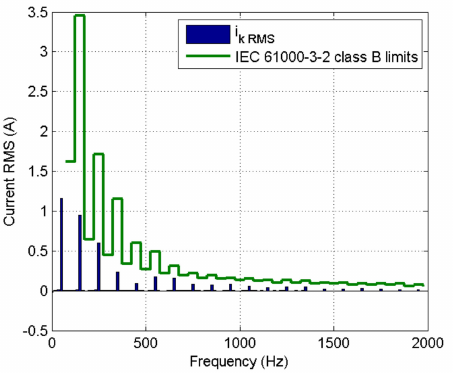
Figure 9. Testing for harmonic current emissions. RMS values of the harmonic components of the current drawn by the tested drive for idle motor conditions at n = 10,000 rpm and for the PWM duty cycle of 67.7%. The duty cycle was chosen for the rated speed. All higher harmonics are well below standard defined limits. This was to be expected, as the current is drawn from the mains while the tool is idling is relatively